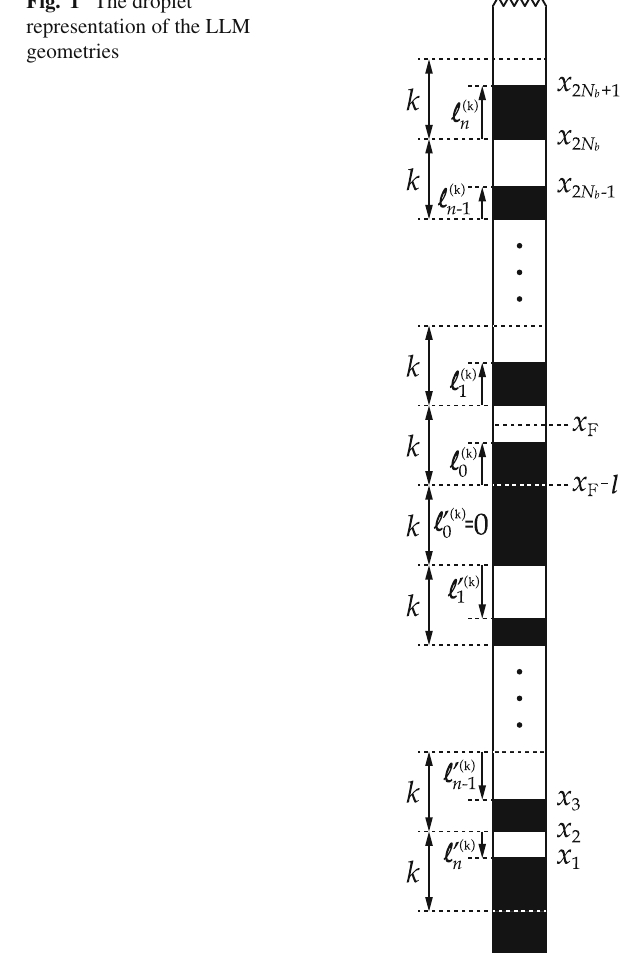
Fig. 1 The droplet representation of the LLM